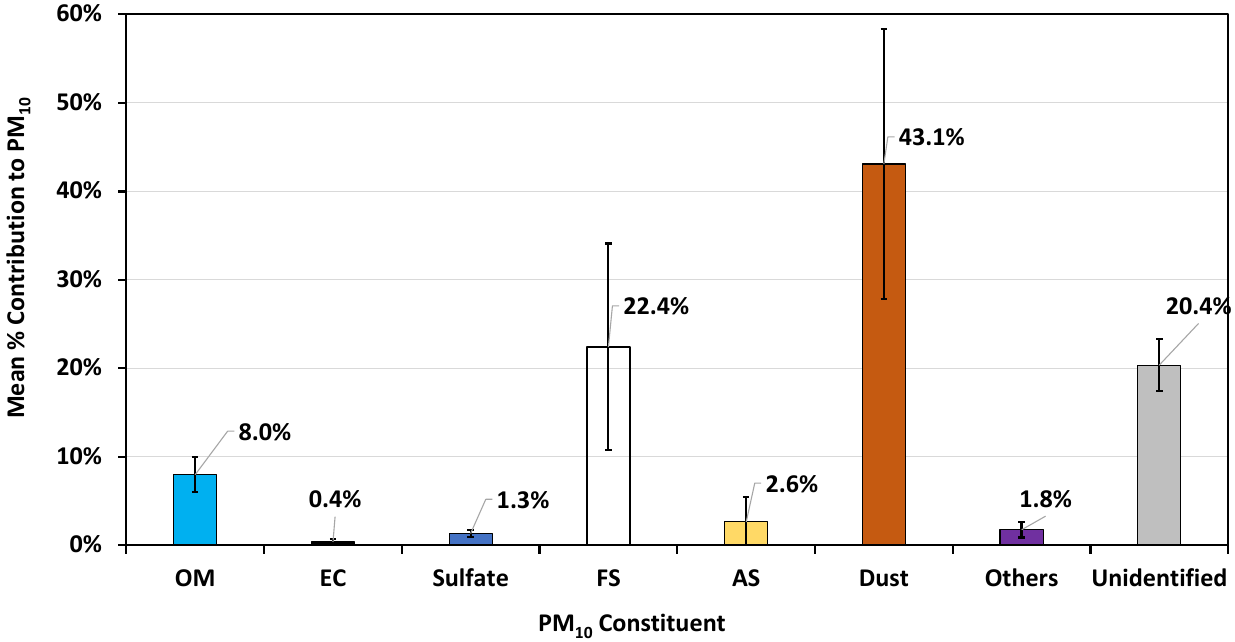
Figure 12. The mean source attribution of PM 10 , representing the eight exceedance days between April and October 2021. Note: OM, organic matter; EC, elemental carbon; FS, fresh sea salt; and AS, aged sea salt. Error bars represent the standard deviation of the mean based on the eight sample days.